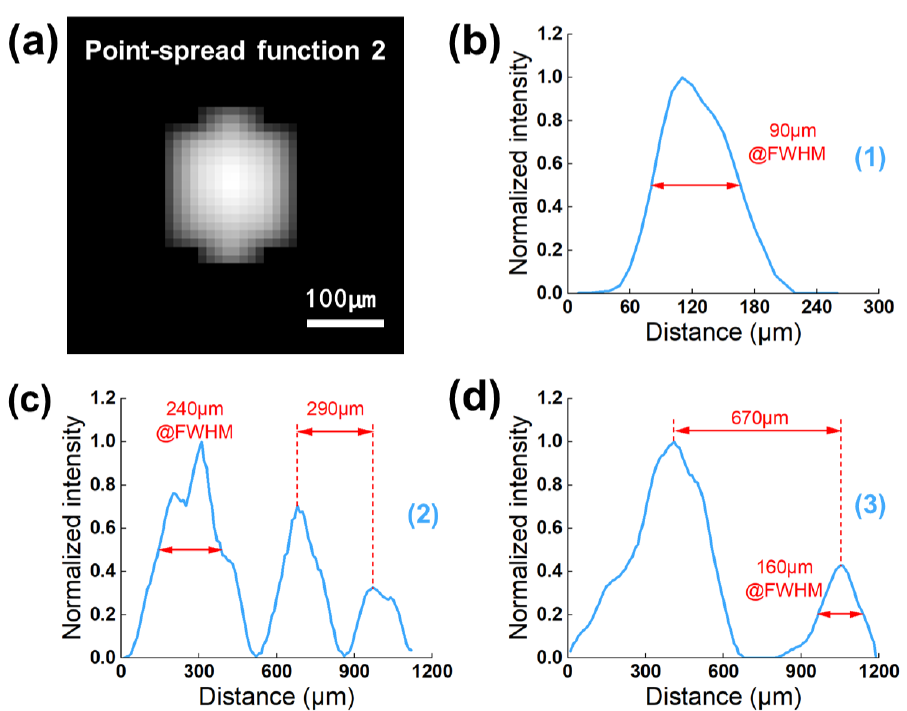
Figure 9. ( a , b ) Examples of the real-time US images after three-frame difference processing under different moments. ( c , d ) Examples of the real-time conventional B-mode image and its superim- posed image with the reconstructed super-resolution microvessel image in vivo. Eyeball region is marked in white dotted lines. ( e , f ) Super-resolution microvessel density map and flow speed map inside OCM of SD rat. Three-line markers in ( e ) were used to calculate the detectable resolution and the resolved distance.